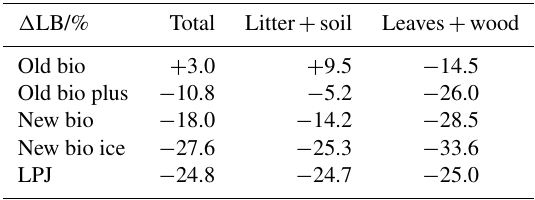
Table 2. Percentage change of biomass carbon in the cooling exper- iment for total biomass and divided into reservoirs above and below ground. DCESS model with the old biosphere scheme, with and without the crude approach for vegetation area limiting (see text), and with the new biosphere scheme with and without prescribed ice sheet expansion, and LPJ model study presented in Gerber et al. (2004). (cid:49) LB/% Total Litter + soil Leaves + wood Old bio +